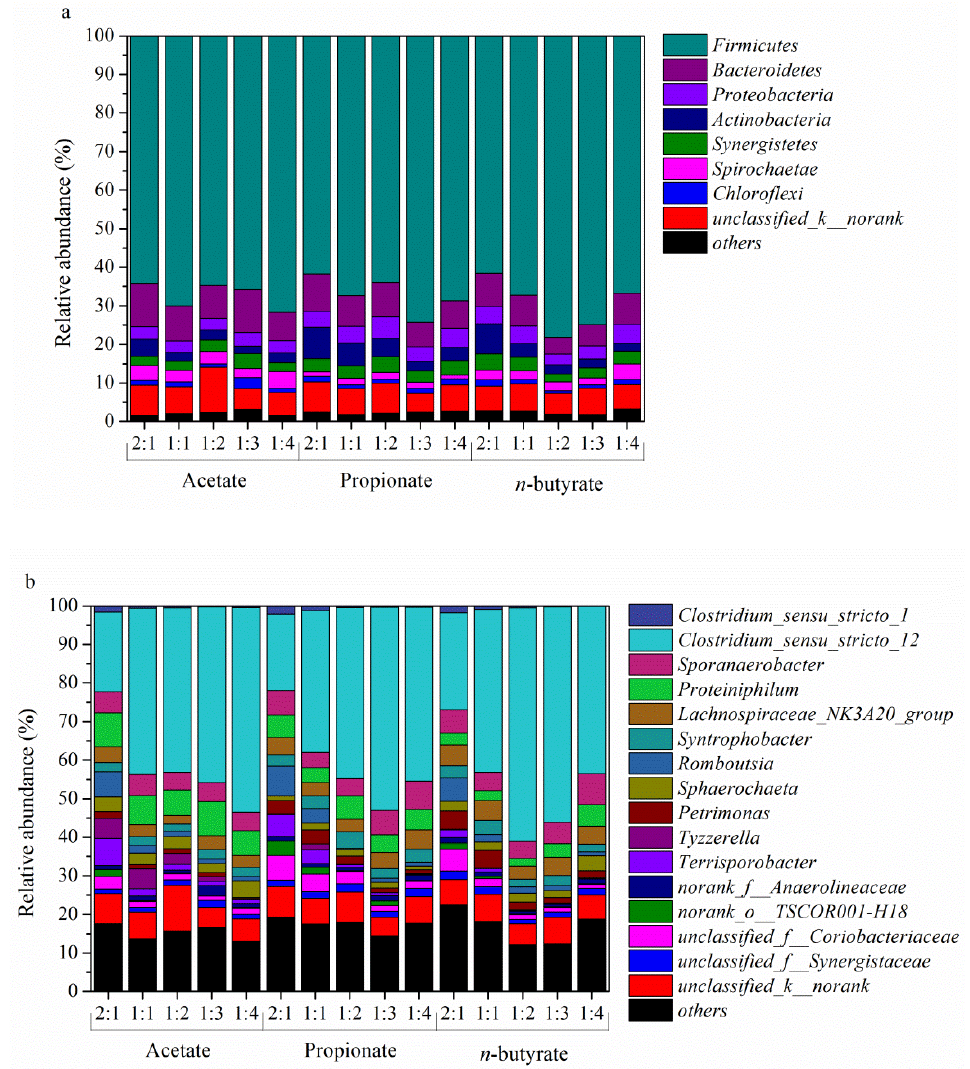
Figure 10. Bacterial abundance in chain elongation systems on phylum level ( a ) and on genus level ( b ).